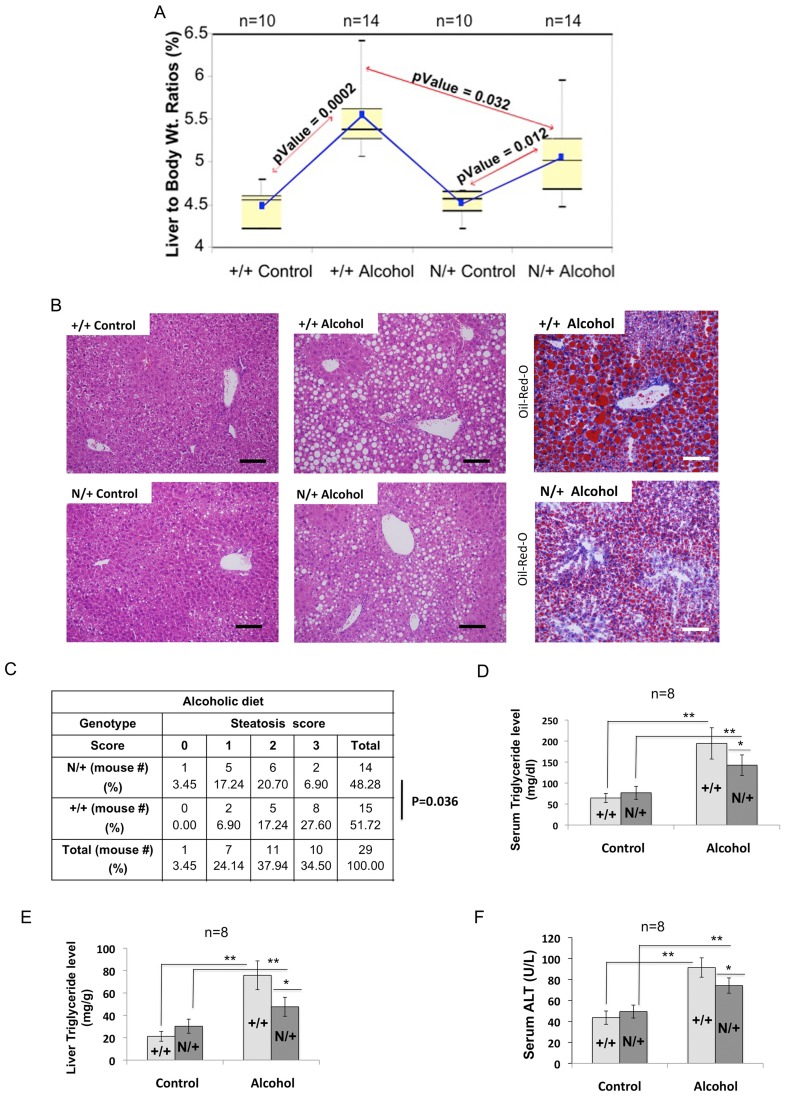
Hypomorphic mice are less sensitive than wild type mice to alcohol-induced hepatic steatosis.
A. Alcohol-induced increase in liver weight to body weight ratio (LW/BW) is significantly less in Dnmt1
N/+ mice compared to wild type mice. Whisker-box plot of LW/BW in Dnmt1
+/+ (+/+) and Dnmt1N/+ (N/+) mice fed alcohol and pair-fed control diets for 6 weeks. The boxes show medians and upper/lower quartiles of the data, while the whiskers indicate the minimum and maximum values. The blue lines connect the mean values in consecutive boxes. B. Hepatic steatosis is less pronounced in Dnmt1
N/+ than in Dnmt1
+/+ mice fed the liquid alcohol diet for 6 weeks. Representative H&E and Oil-red-O stained liver sections are shown. The scale bars in the photographs are 20 µm. C, D. Steatosis score in mice fed the liquid alcohol (C) and pair-fed control (D) diets was determined by two blinded pathologists. Score criteria: score = 0: no steatosis; score = 1: microsteatosis; score = 2: microsteatosis and mild macrosteatosis; score = 3: severe macrosteatosis. Statistical analysis was performed using Cochran Armitage trend. D&E. Serum and liver triglyceride levels are significantly lower in mutant mice compared to WT mice fed the alcohol diet. Serum was collected from mice by cardiac puncture. Serum and liver TG were analyzed using the VetAce system. F. Alcohol-induced liver damage in Dnmt1
N/+ mice is considerably less than that in Dnmt1
+/+ mice. Serum ALT was measured using VetAce system. Statistical significance was determined by Student’s 2-tailed t test. Single and double asterisks represent P-values ≤0.05 and ≤0.01, respectively.